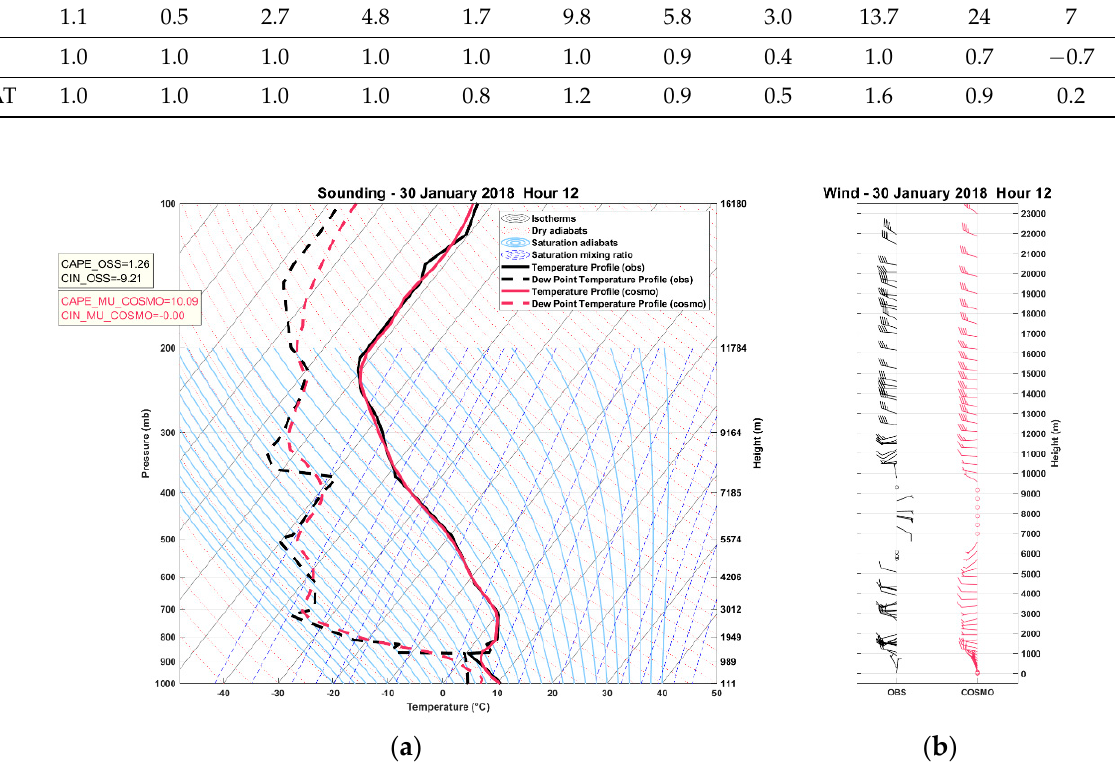
Figure 11. Vertical profiles of temperature and dew point ( a ) and of wind ( b ) provided by the model and by radiosounding for 30 January 2018, 12 UTC.